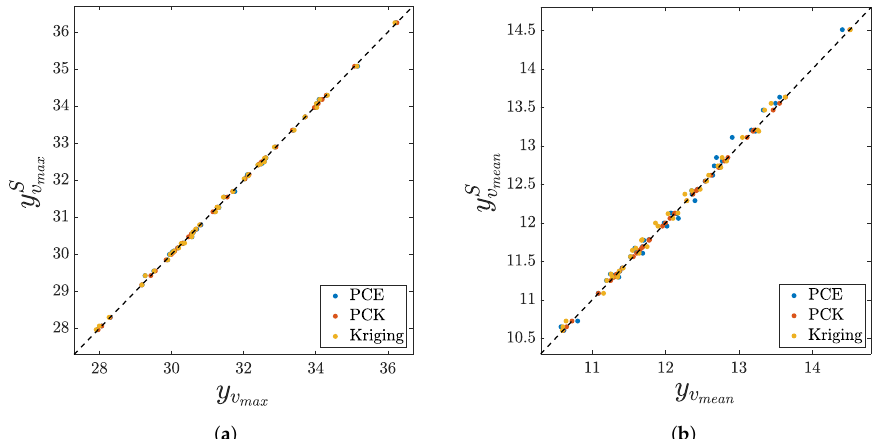
Figure 7. Comparison between QoI measurements and corresponding surrogate predictions